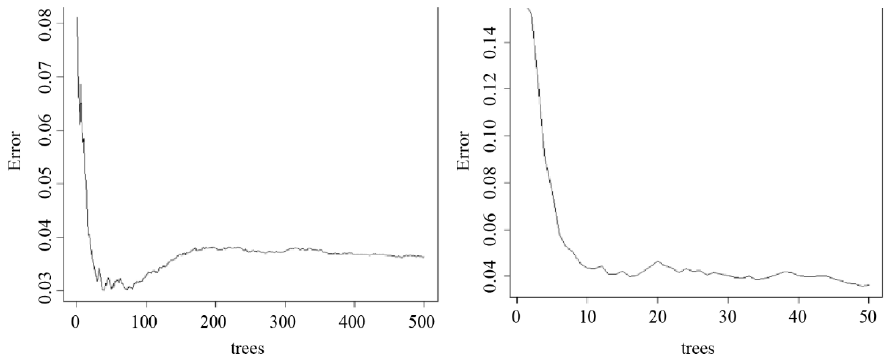
Figure 14. Random forest algorithm (tree case 500, 50).